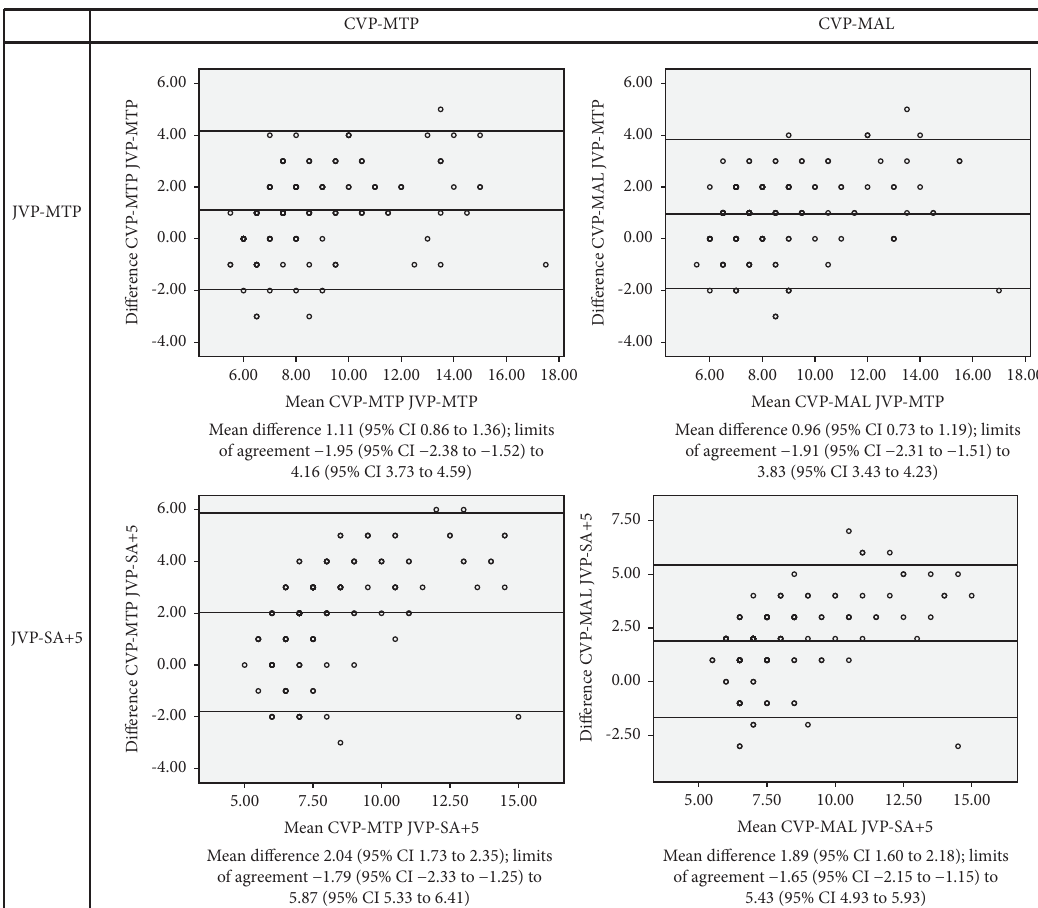
Figure 3: Te Bland–Altman plots of JVP-MTP and JVP-SA+5 with CVP-MTP and CVP-MAL of 150 subjects. CVP-MAL: central venous pressure (CVP) measured from the midaxillary line (MAL) at the fourth intercostal space; CVP-MTP: CVP measured from the midthoracic plane (MTP) at the anterior fourth intercostal space level; JVP-MTP: jugular venous pressure (JVP) measured from the MTP; JVP-SA+5: JVP measured from the sternal angle (SA) with the addition of